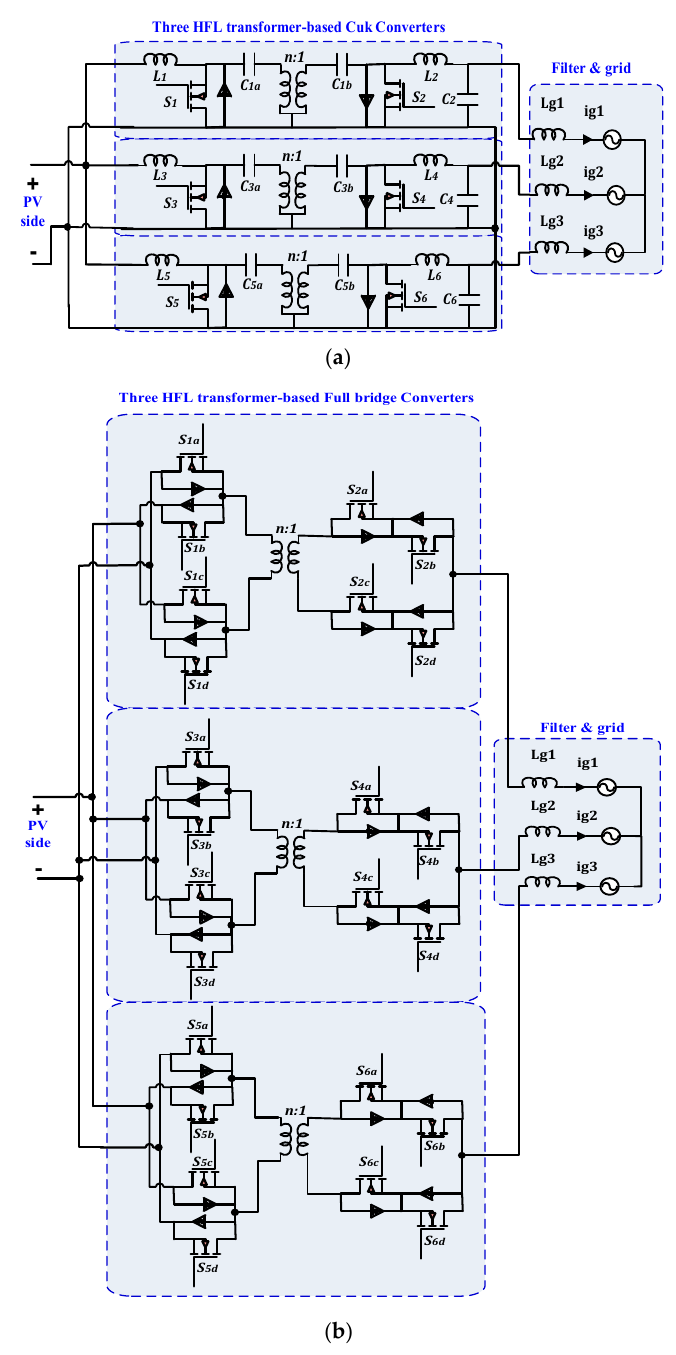
Figure 9. Isolated differential mode three-phase microinverter topologies: ( a ) isolated differential Cuk